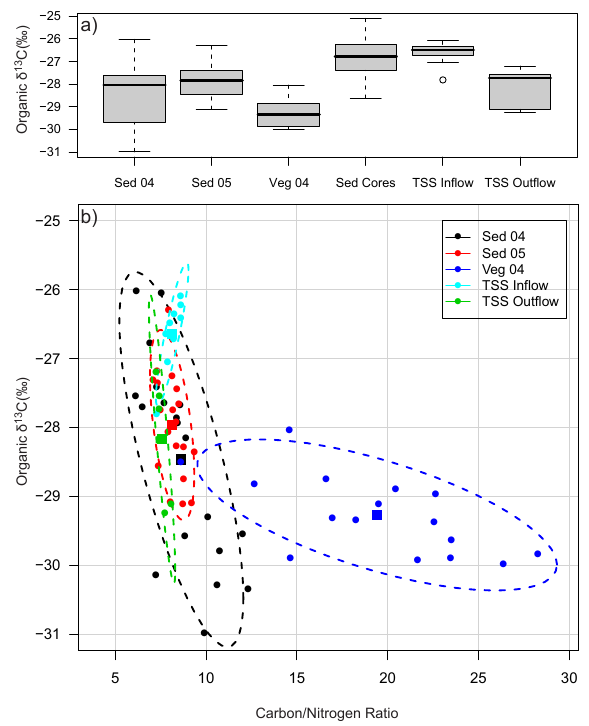
Fig. 6. Boxplot of δ 13 C (a) and xy-plot of δ 13 C vs. C:N ratio (b) for different wetland carbon sources. The middle of each boxplot indicates the median value. The upper and lower edges of each boxplot indicate the 75th and 25th percentiles, respectively. The ends of the vertical lines indicate the minimum and maximum data values. Points outside of the vertical lines indicate outliers. The ellipsoids in (b) represent 80% confidence intervals.